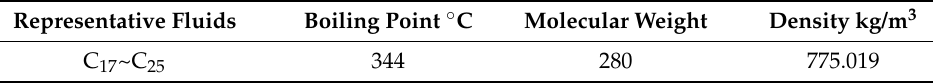
Table 6. Properties of representative